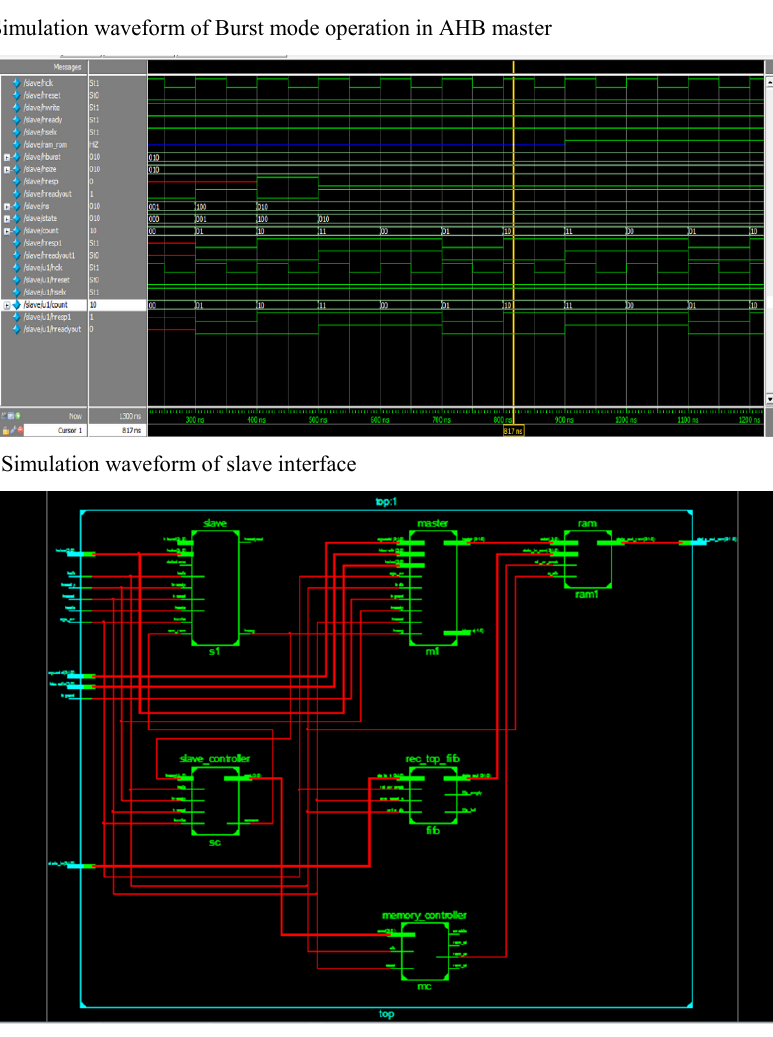
Fig. 11. Top architecture of AHB system